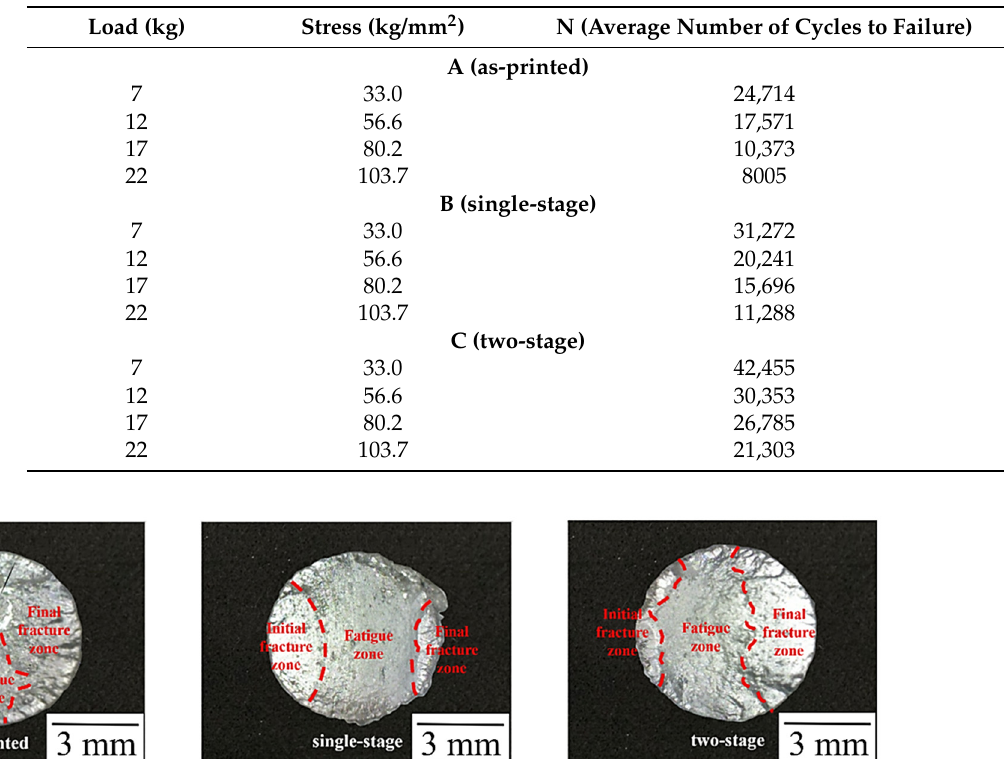
Table 6. Fatigue resistance of SLM Al–Mg–Sc–Zr alloys.